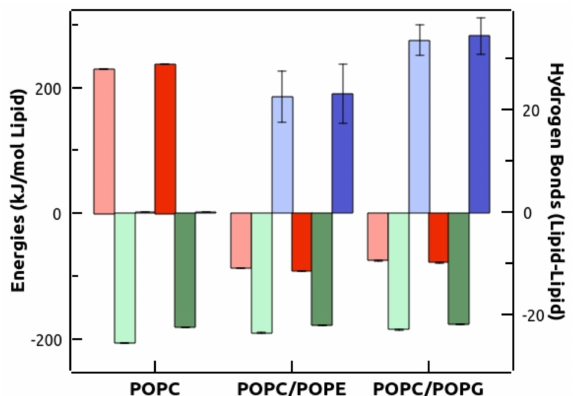
Figure 9. Phospholipid–phospholipid energies of interaction and hydrogen bonding for various lipid compositions, in the absence (light colors) and presence (dark colors) of TMX at 25.6 mol%. Left axis: electrostatic (red) and hydrophobic (green) interactions. Right axis: hydrogen bonds (blue). Error bars represent the SD of the trajectories